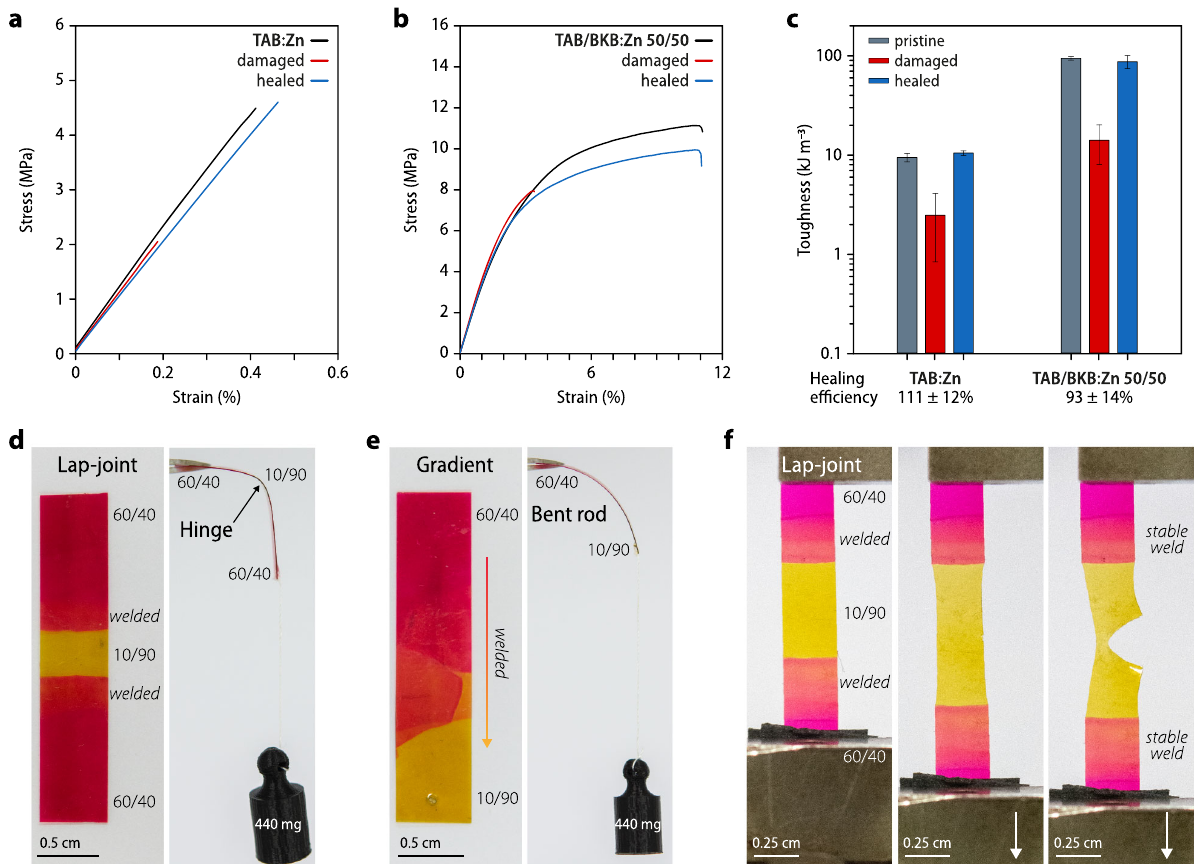
Fig. 4 Healing and MSP copolymers with variable mechanical properties. a , b Stress – strain curves of pristine, damaged, and healed ( a ) TAB:Zn and ( b ) copolymers with a TAB/BKB ratio of 50:50 wt/wt%. c Comparison of the toughness of pristine, damaged, and healed samples of TAB:Zn and copolymers with a TAB/BKB ratio of 50:50 wt/wt% (error bars represent the standard deviation of n = 3 – 4 individual measurements). d Photographs of a welded sample containing parts with TAB:BKB ratios of 60:40 wt/wt% (stiff, red-dyed) and 10:90 wt/wt% (soft, yellow-dyed). The soft segment acts as a hinge. e A compositionally graded fi lm of MSP copolymers with TAB:BKB ratios of 60:40 wt/wt% (stiff, red-dyed) and 10:90 wt/wt% (soft, yellow-dyed) features a mechanical property gradient and bends under load. f The modulus of the welded sample shown in ( d ) is lowest in the segment with a TAB:BKB ratio of 10:90 wt/wt% (yellow-dyed) and the photographs show how the sample fails in this part upon uniaxial tensile